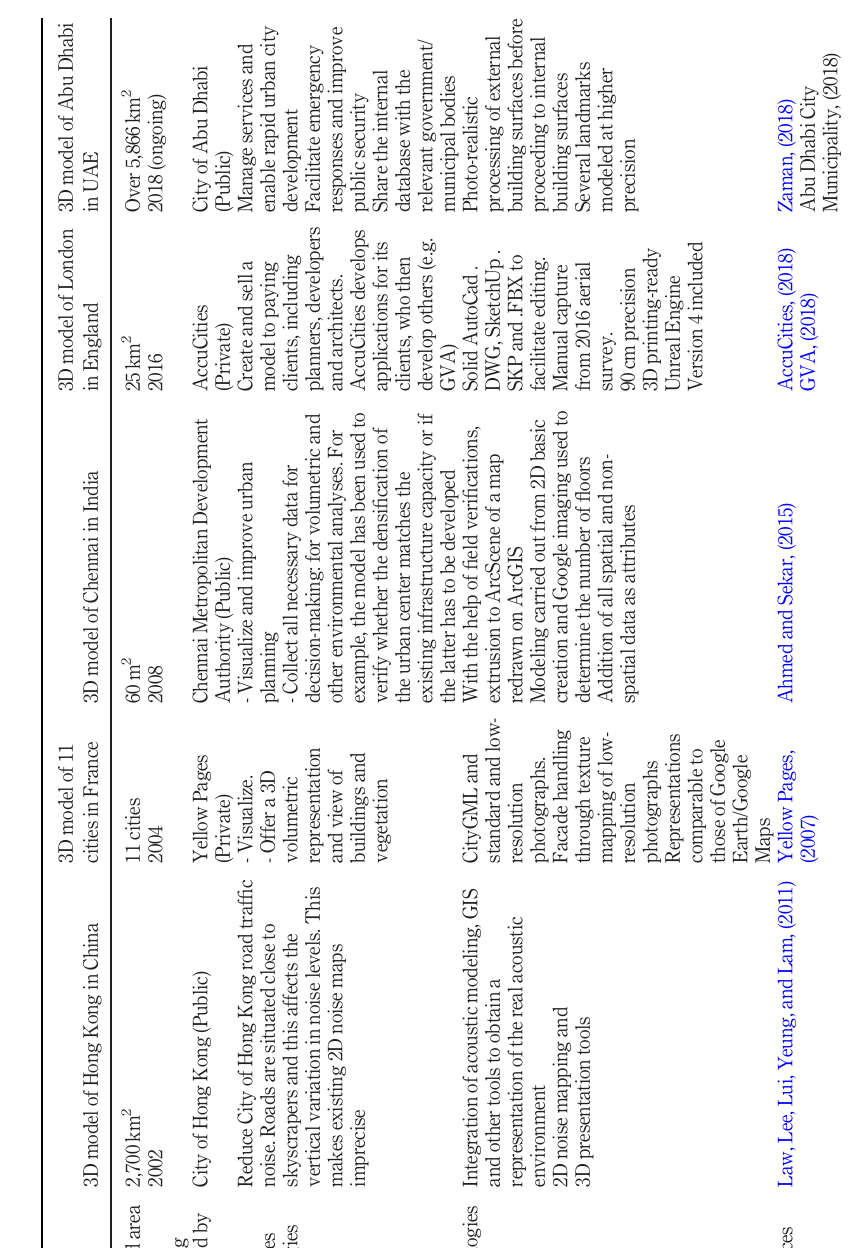
Table I. Different approaches to designing 3D city